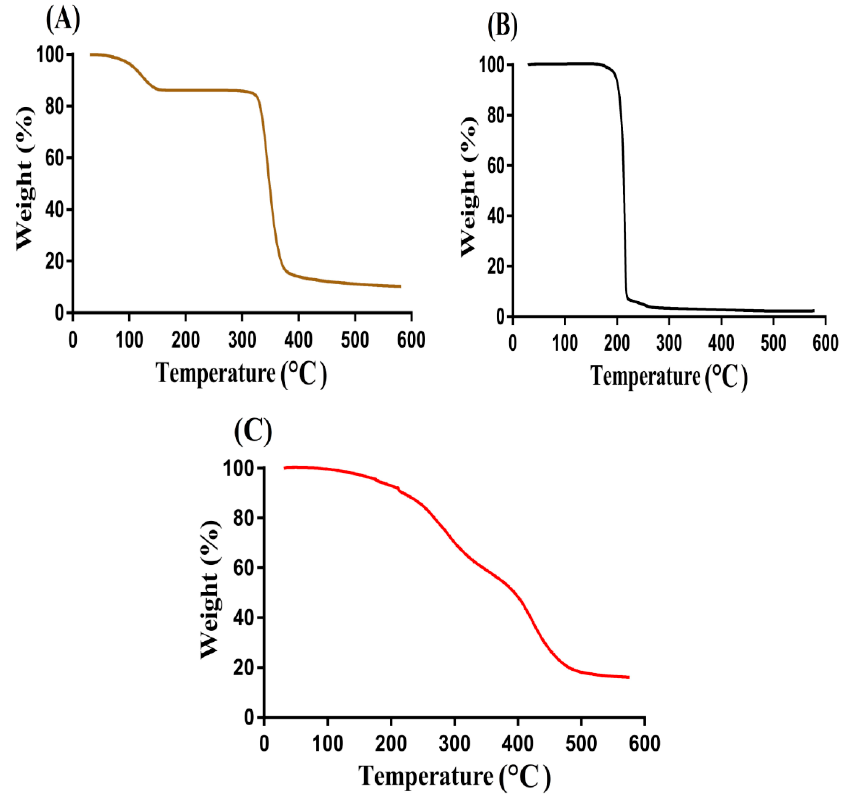
Figure 3. TGA of ( A ) β -CD, ( B ) Ia, and ( C ) β -CD- g -P(Aa/Ia) hydrogel.